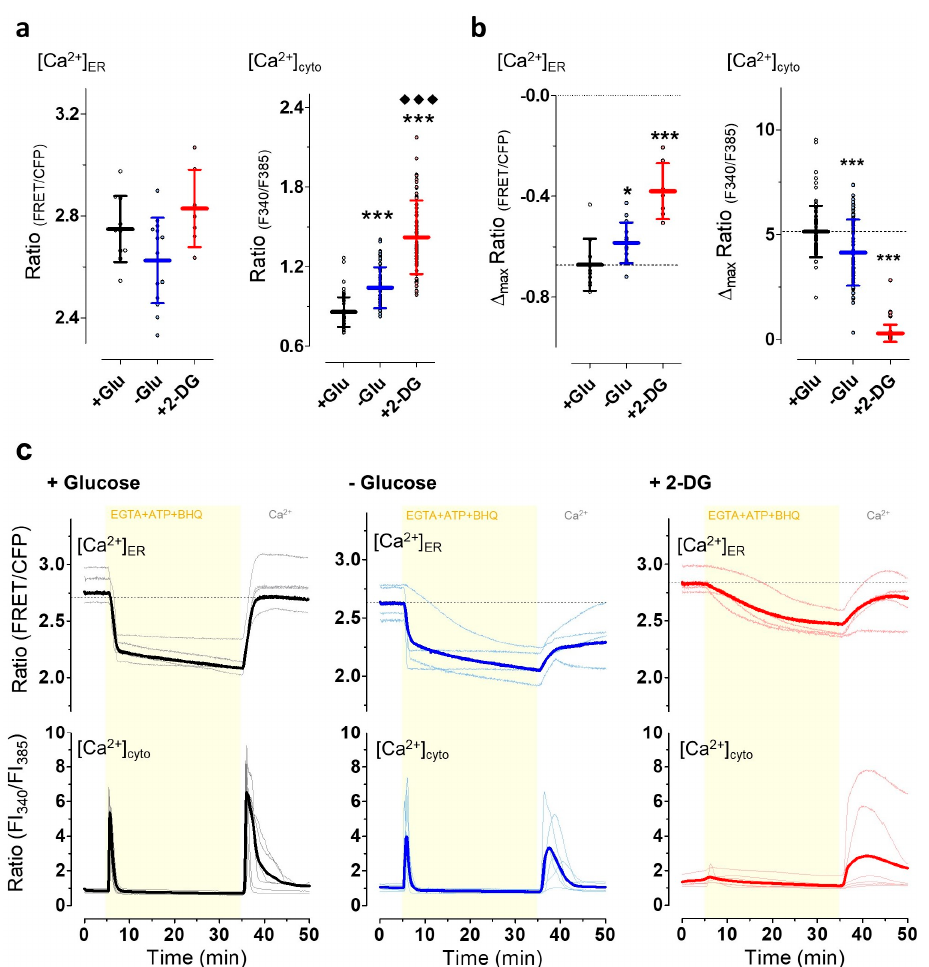
Figure 5. Mild and severe energy depletion affects the cytosolic and ER Ca 2+ homeostasis. For measurement of cytosolic calcium dynamics HeLa cells were loaded with Fura-2 (+ Glu, n = 78 cells from four independent experiments; − Glu, n = 84 cells from three independent experiments; + 2-DG n = 73 cells from four independent experiments), for visualizing ER-calcium HeLa cells expressing D1ER were measured (+ Glu, n = 10 cells; − Glu, n = 14 cells; and + 2-DG n = 7 cells; each from three independent experiments). ( a ) Aligned dot plot and mean ± SD representing FRET ratio values of D1ER (i.e., [Ca 2+ ] ER , left) and Fura-2 ratio values (i.e., [Ca 2+ ] cyto , right) of unstimulated HeLa cells that were kept in the presence of 10 mM glucose (+ Glu, black), upon glucose starvation for 30 min ( − Glu, blue), or cell treatment with 10 mM 2-DG for 30 min (+ 2-DG, red). *** significant versus + Glu p < 0.001, (cid:7)(cid:7)(cid:7) significant versus − Glu p < 0.001, Mann–Whitney U test; ( b ) Aligned dot plot and means ± SD showing the maximum change in ratio signals of D1ER (left) and Fura-2 (right) upon cell stimulation with ATP (100 μ M) and 2,5-di-t-butyl- 1,4-benzohydroquinone (BHQ) (15 μ M) in the absence of extracellular Ca 2+ (i.e., EGTA), as also shown in panel c. * significant versus + Glu p < 0.05, *** significant versus + Glu p < 0.001, Mann–Whitney U test; ( c ) ER (upper panel) and cytosolic (lower panel) Ca 2+ signals over time in the presence of 10 mM glucose (+ Glu control, black, left panels, n ER = 10 cells, n cyto = 78 cells), the absence of glucose ( − Glu, blue, middle panels, n ER = 14 cells, n cyto = 84 cells), and upon cell treatment with 10 mM 2-DG (30 min prior to imaging experiments, + 2-DG red, right panels, n ER = 7 cells, n cyto = 73 cells). As indicated, cells were stimulated with a mixture of 100 μ M ATP and 15 μ M BHQ in the absence of extracellular Ca 2+ , i.e., in the presence of 0.1 mM EGTA. Subsequently, ATP and BHQ were removed and 2 mM Ca 2+ was re-added via a perfusion system.